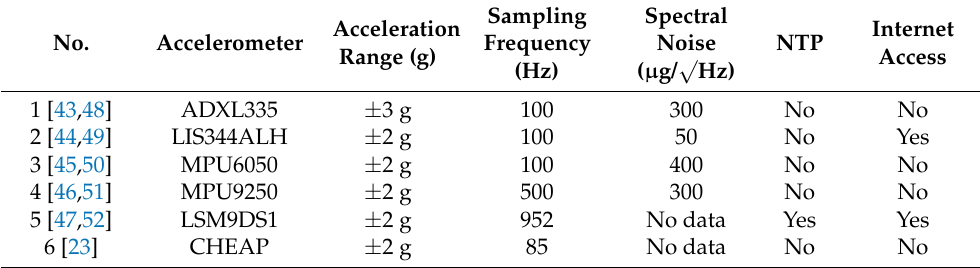
Table 1. Low-cost solutions in the literature to measure